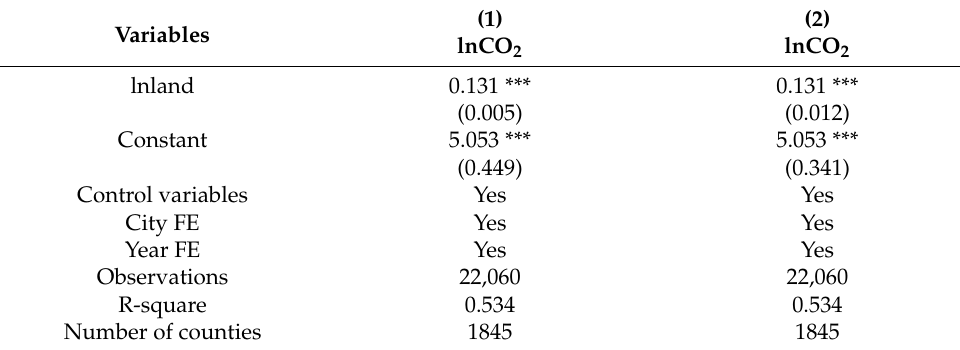
Table 5. The results of robustness tests